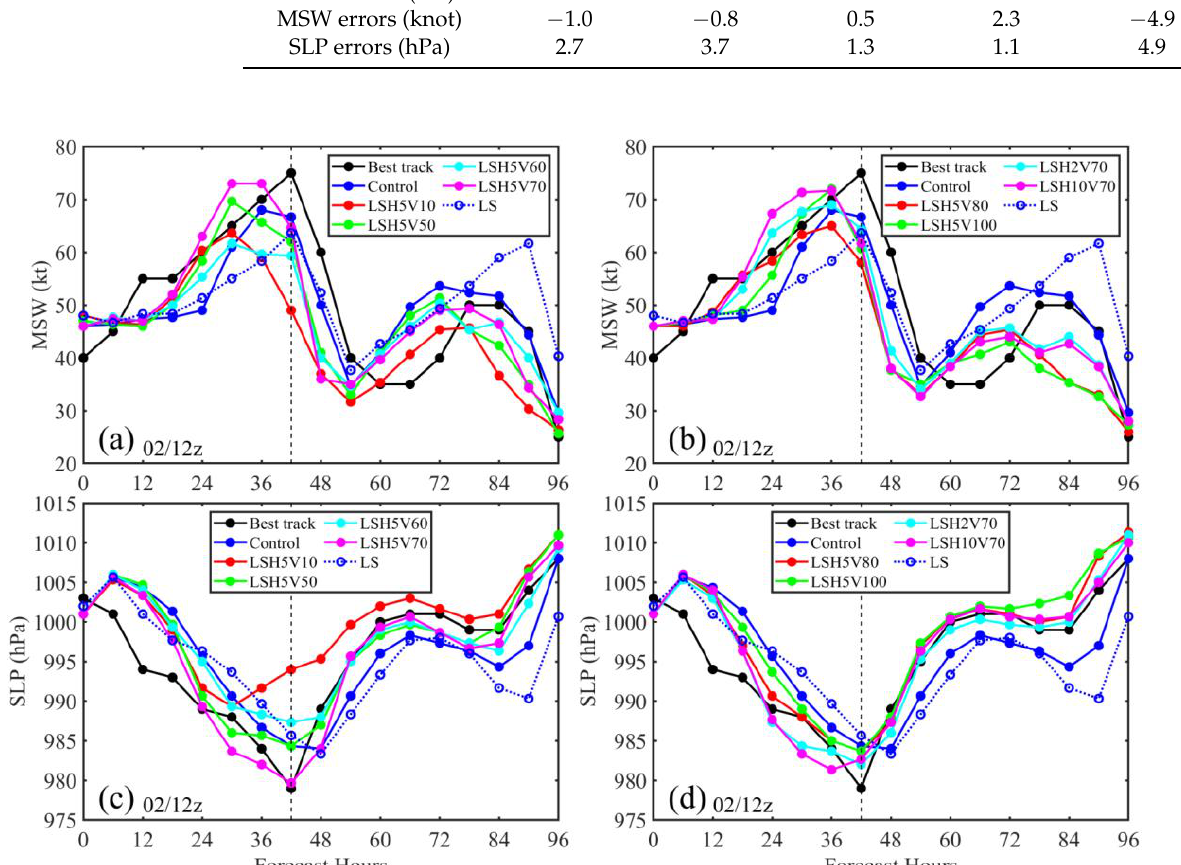
Figure 6. Comparison of the forecast ( a , b ) MSW and ( c , d ) SLP for Hurricane Earl for different DWL wind speed thinning experiments against Control and best track at 12 UTC 2 August 2016.